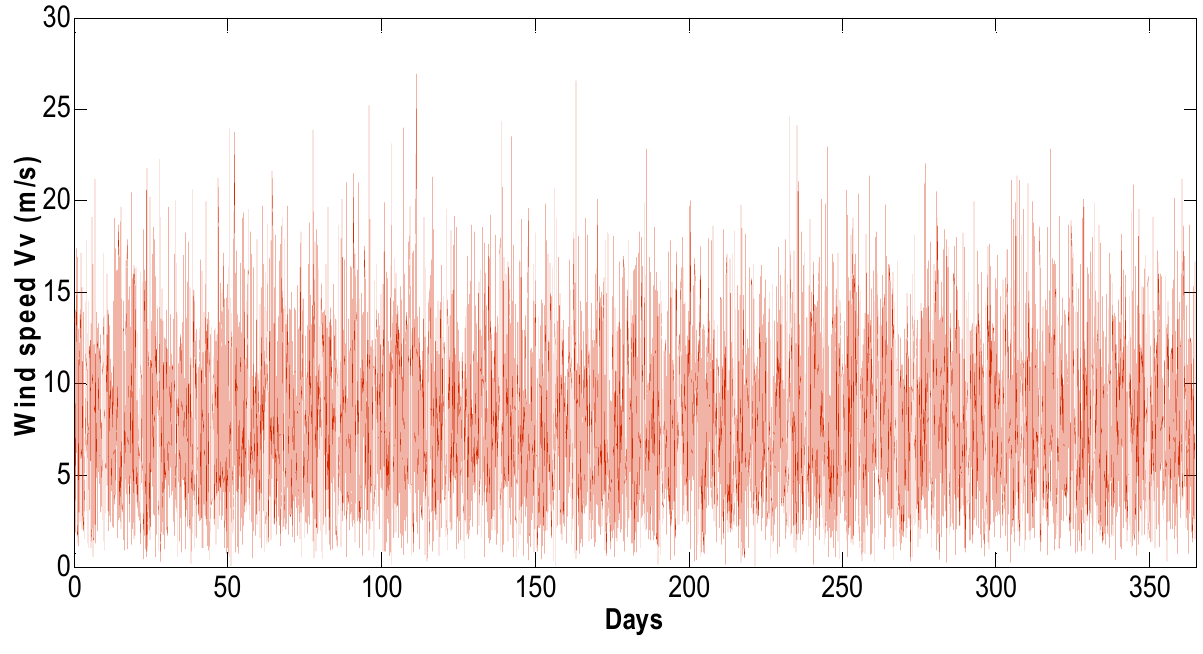
Figure 3. Wind speed profile during a year.